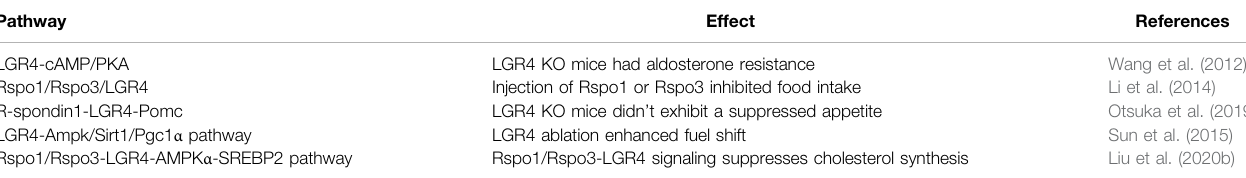
TABLE 3 | Regulatory effects of LGR4 gene on metabolic diseases.